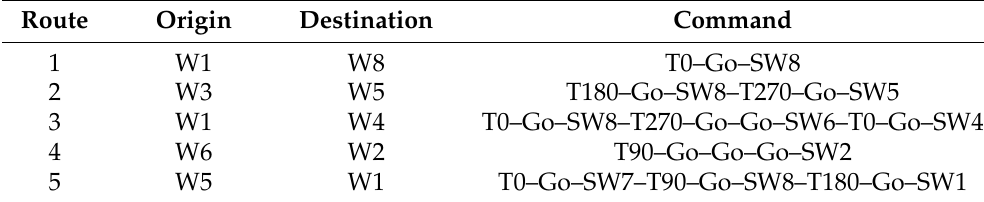
Table 2. Robot navigation command line. T θ means the robot should turn to the θ -degree ( θ = 0,90,180,270 ) . Go means robot should go straight. SWx means the robot must stop at worksta- tion x = { 1, . . . ,8 }